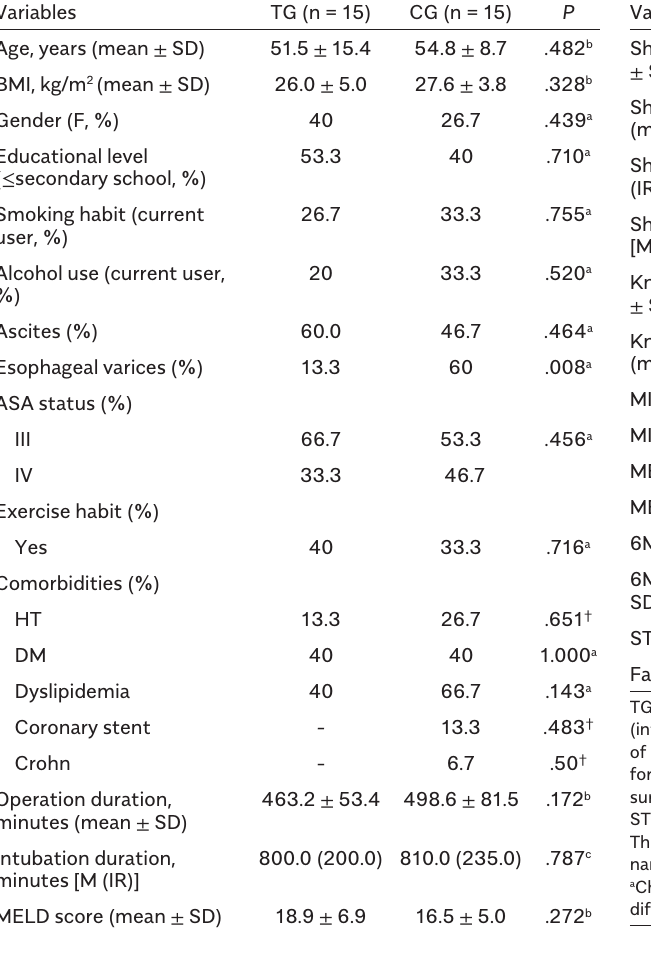
Table 1. Baseline Demographic and Clinical Characteristics of the Participants